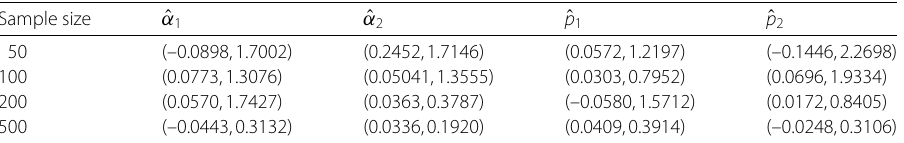
Table 4 Bias and SE of the parameters in Models II with λ = 2 Sample